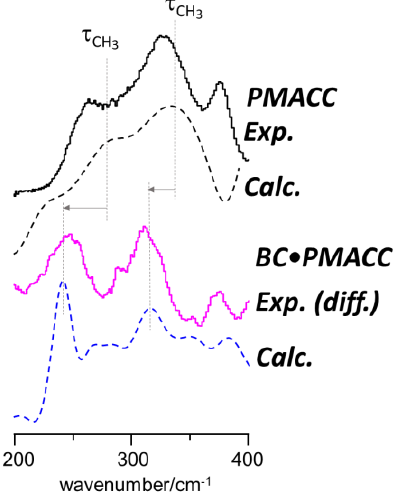
Figure 8. Observed (full lines) and calculated (dashed lines) INS profiles for the methyl torsions in PMACC. Top lines are an insight of Figure 4, and compare the experimental INS spectra of PMACC with the with the calculated spectrum for the methyl groups bound to chloride ions in the isotactic triad; bottom lines compare the INS difference spectra of BC•PMACC with the calculated profile for free methyl groups (no chloride ions) in the isotactic triad.